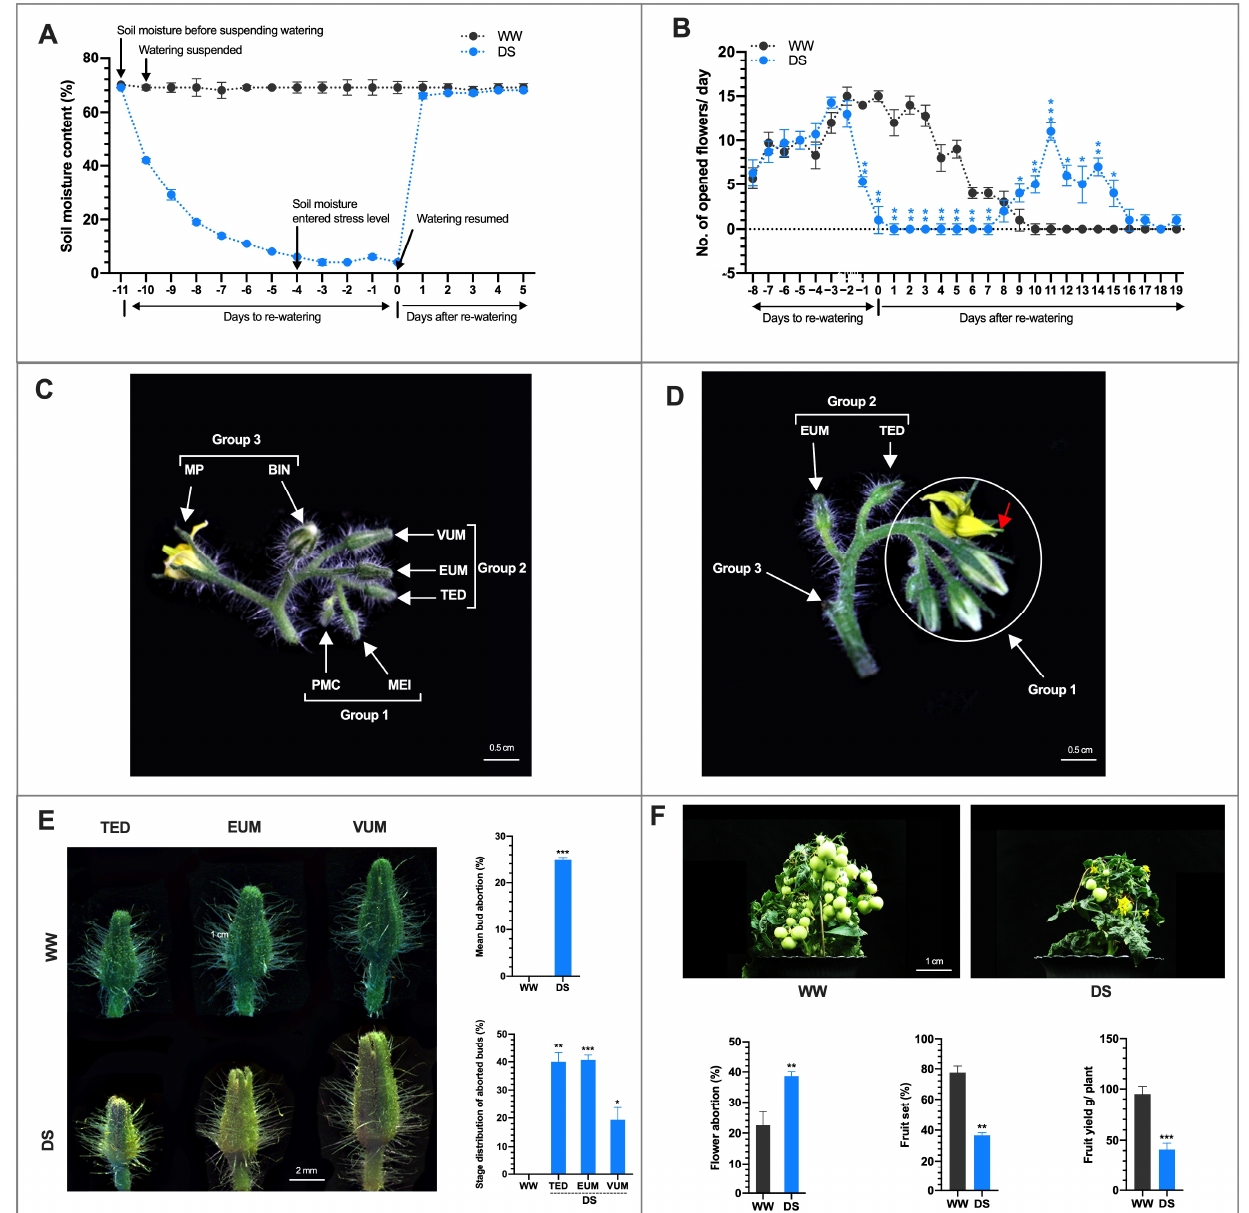
Figure 1. Tomato anther development and fruit yield under drought stress. ( A ) Soil moisture content (%) during the period watering was suspended to 5 days after re-watering (DARW). Data points and error bars represent means ( n = 16). ( B ) Number of opened flowers/day before and after rewatering. Data points represent mean ±SD ( n > 10). ( C ) A truss from DS plant at 0 DTRW with one newly opened flower and an array of unopened floral buds at different stages of development. The BIN floral bud was −1 DAA. ( D ) A DS truss similar to C above, 9 DARW. The BIN (−1 DAA) floral bud that opened I DARW had its opened flower aborted and dropped with only a remnant of the flower stalk left. The group 2 floral buds did not recover from the DS and had aborted. ( E ) Drought stress-induced floral bud abortion at three specific developmental stages namely tetrad (TED), early uninucleate microspore (EUM) and vacuolated uninucleate microspore (VUM). For details see Figure S1. The DS floral buds were declared as ‘aborted’ and sampled on 9 DARW when younger floral buds in group 1 began to flower (Figure 1D). Values are means ±SD ( n = three biological replications each with aborted floral buds >39). ( F ) Drought caused open flower abortion, reduction in fruit set and fruit yield in tomatoes. Values are means ±SD ( n = three biological replications, each with >140 opened flowers assessed. * p < 0.05; ** p < 0.01; *** p < 0.001 ( t - test).